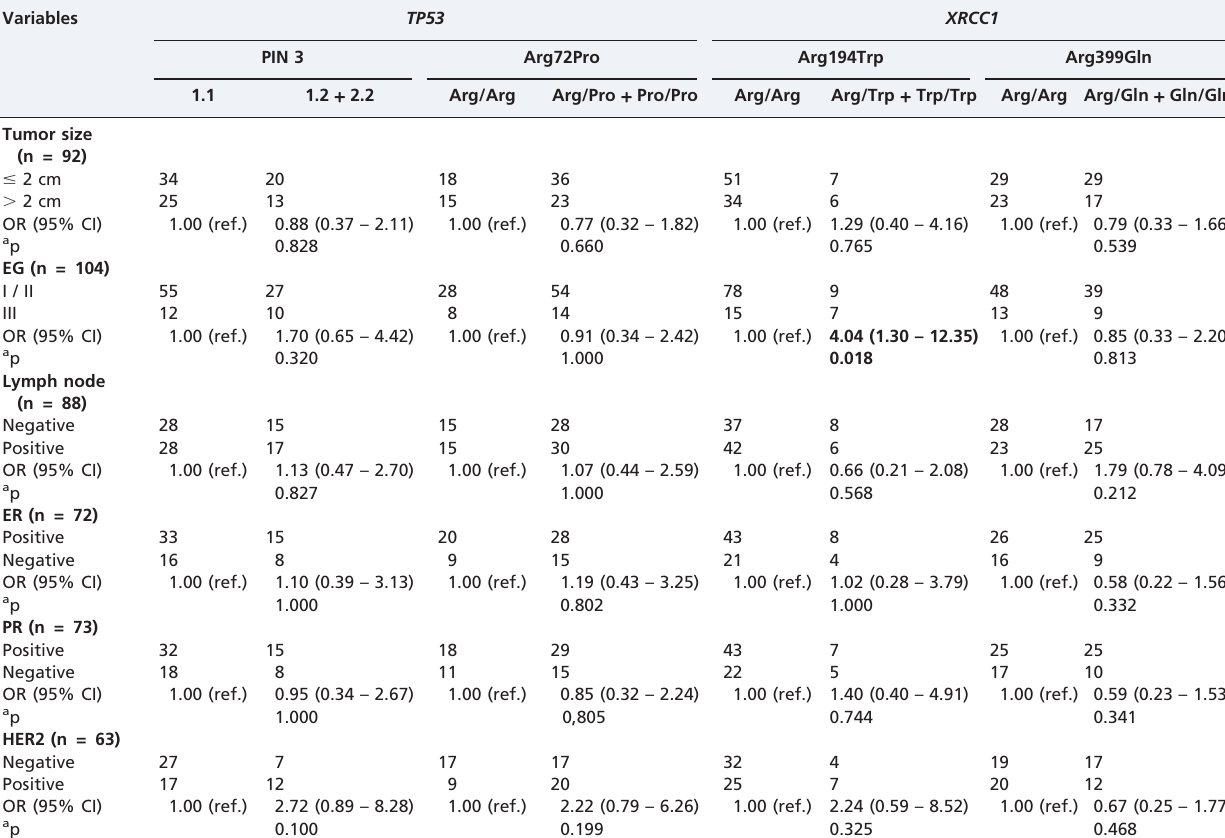
Table 3 - Associations between TP53 and XRCC1 polymorphisms and tumor characteristics